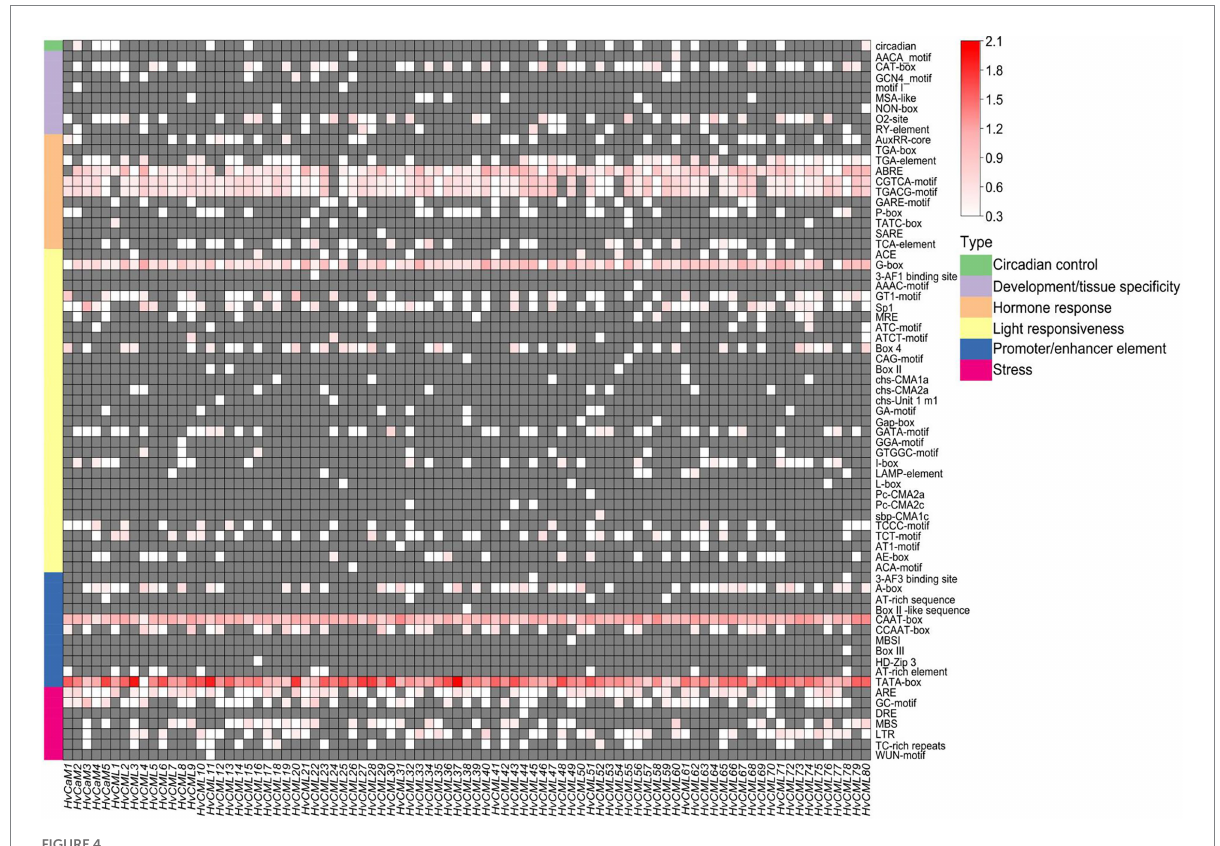
FIGURE 4 Cis -acting elements in promoter regions of HvCaMs/CMLs . Cis -acting elements were predicted based on 2 kb sequences upstream of coding sequences of HvCaMs/CMLs . The quantity of cis -acting elements was normalized by log 10 (number + 1) and then used for heatmap